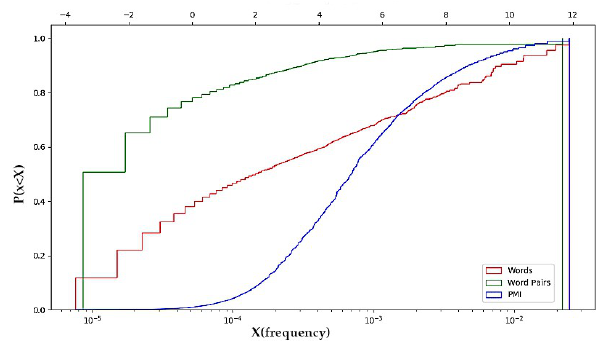
Figure 8. Accumulated distribution map of word frequency, word pair frequency and point mutual information probability.